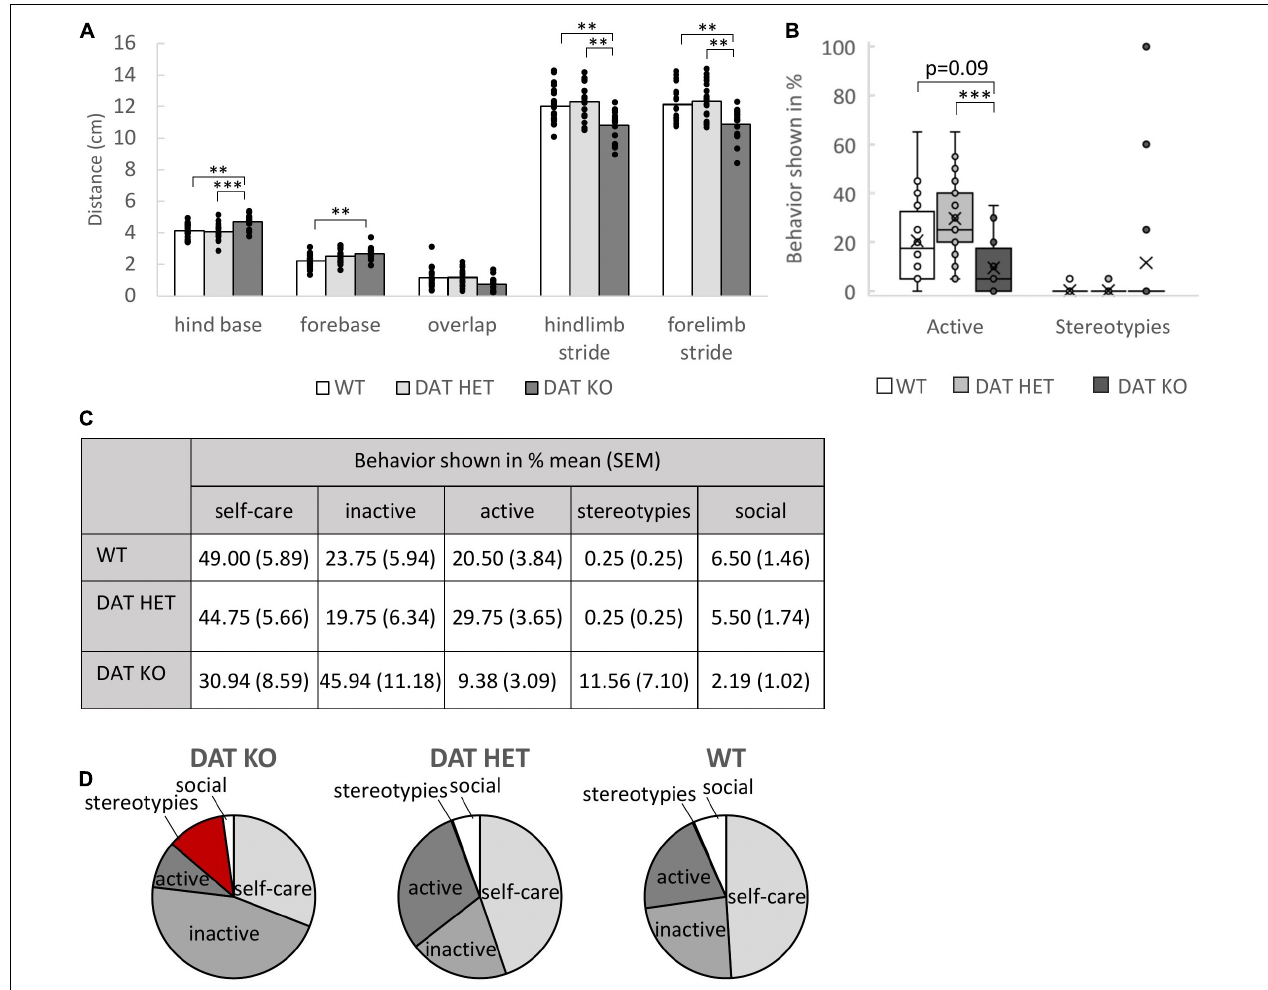
FIGURE 3 | (A–D) Footprint Analysis and Ethogram. (A) Footprint analysis. The bars present the mean length in cm for the different parameters in the footprint analysis and the dots represent all data points. The DAT KO rats had a shorter forelimb as well as hindlimb stride. The hind base (vs. DAT HET and WT) and the fore base (vs. WT) were significantly broader in the DAT KO rats. Sample size: DAT KO ( n = 16), DAT HET ( n = 20), WT ( n = 20). (B) Boxplots illustrating the distribution of the categories “active” and “stereotypies” during the 10 min home-cage observation for the three genotypes. (C) Table presenting the distribution of the categorized behaviors. (D) Pie charts showing the distribution of the categorized behaviors for the different genotypes. (B,D) Ethogram. The DAT KO rats spent less time with active behaviors, such as walking, jumping, digging, rearing, sniffing or climbing, compared to DAT HET and WT rats. They also showed a higher percentage for stereotypical behaviors (circling, “rocking” and bar mouthing), although there was no genotype effect. Pronounced stereotypic behavior was shown by individual DAT KO rats (boxplot). Sample size: DAT KO ( n = 16), DAT HET ( n = 20), and WT rats ( n = 20). (A-D) : ∗∗ p < 0.01, ∗∗∗ p <